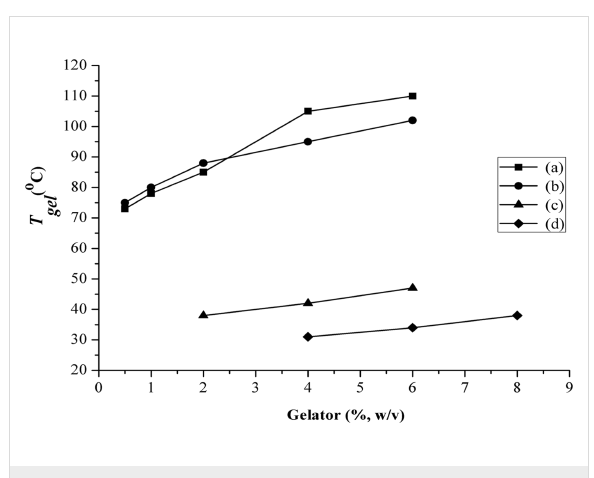
Figure 2: Plot of T gel (gel–sol transition temperature) versus gelators at different concentrations. TPM-G12 in (a) DMSO and (b) propan-1-ol; (c) TPM-G5 in DMSO; (d) TPM-G4 in diethylene glycol.